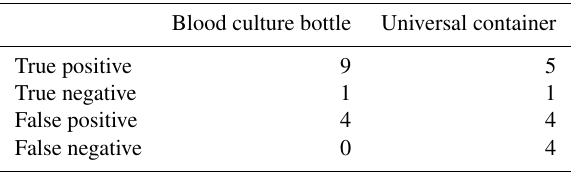
Table 4. Comparison of blood cultures with universal containers; 14 of 17 cases positive for PJI were available for comparison. In three cases no universal container was sent for